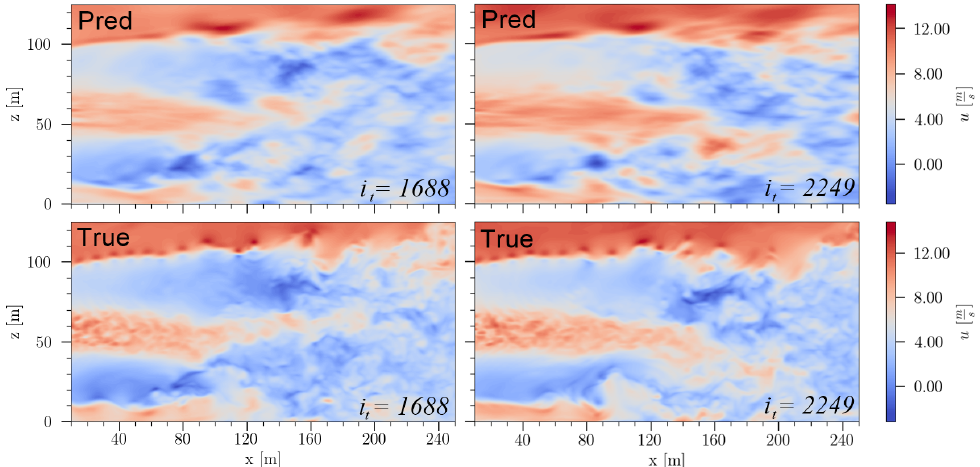
Figure 35. Reconstructed wake field compared against true data for two different time instances.